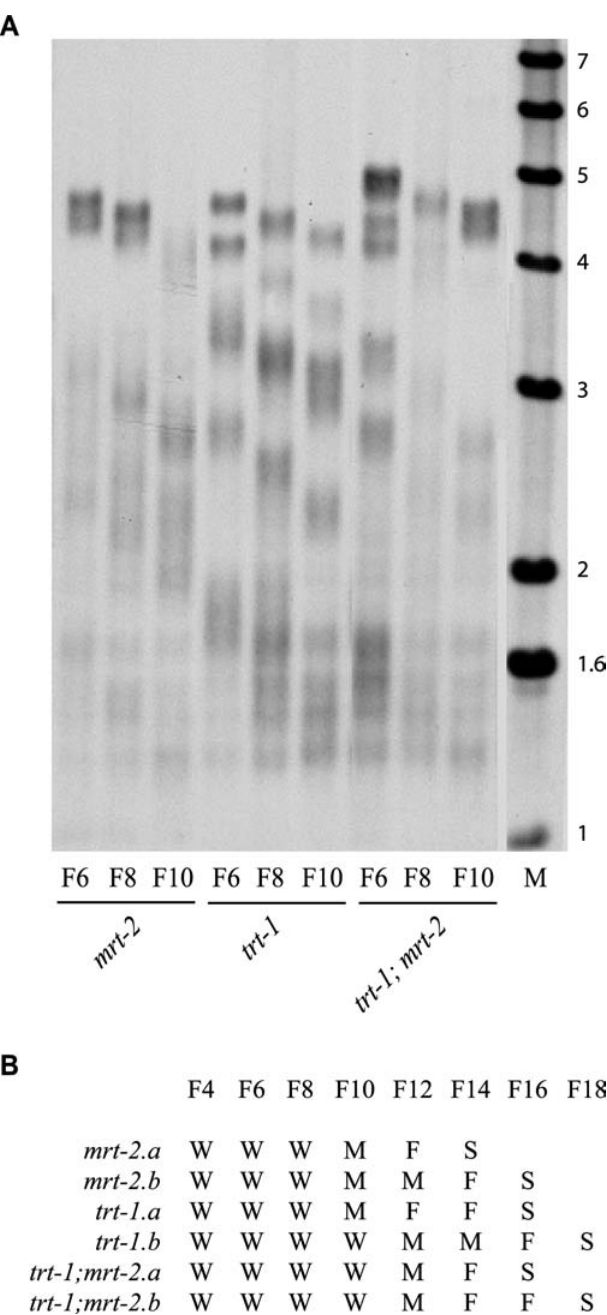
Figure 4. trt-1 and mrt-2 Function in the Same Pathway (A) Progressive telomere shortening of mrt-2 single, trt-1(tm899) single, and trt-1(tm899);mrt-2 double mutant strains. (B) Comparison of late onset of sterility in mrt-2 single, trt-1(tm899) single and trt-1(tm899);mrt-2 double mutant strains. Two independent strains, a and b, are shown for each genotype. Plates were seeded with six L1 animals, and the brood size was scored after 7 days of growth as wild- type (W), medium (M), few (F), and sterile (S) [12]. Note that initial telomere lengths observed for these strains reflect random telomere segregation during a cross. Therefore, the rate of telomere erosion is a more significant measure of additivity than are differences in initial telomere length or the time to sterility. Sizes of DNA fragments are indicated to the right (kb). DOI: